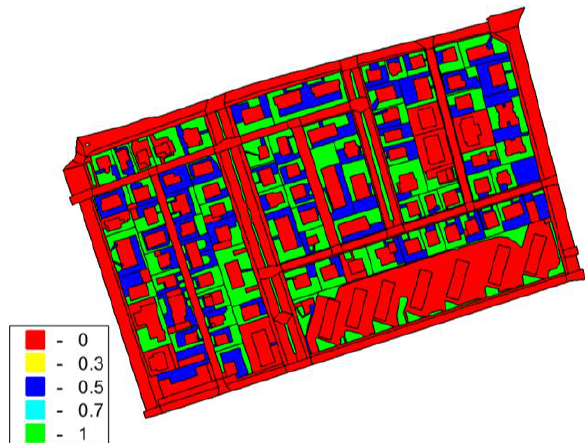
Figure 4. BAF classification for test area 7